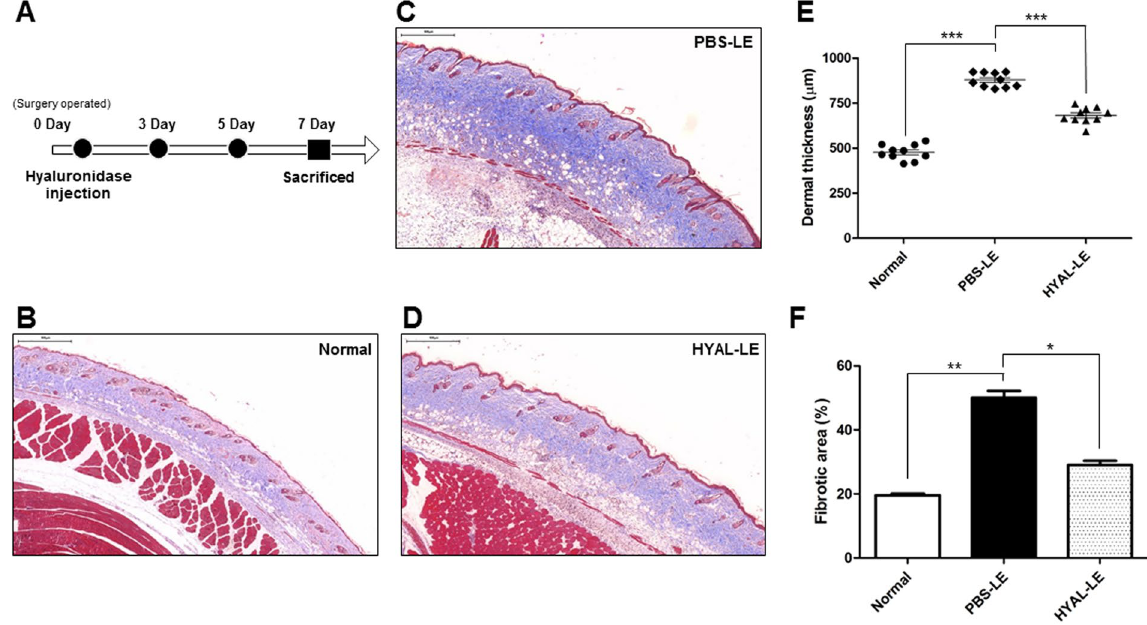
Figure 2. Subcutaneous injection of hyaluronidase alleviates lymphedema in a mouse model. At 7 days postsurgery, PBS-injected mice with lymphedema (PBS-LE) and hyaluronidase-injected mice with lymphedema (HYAL-LE) were sacrificed. Cross-sections of the legs with edema were then analyzed. ( A,B , C ) Representative Masson’s trichrome staining of fibrotic areas. Scale bar = 500 μ m. ( D,E ) Image J analysis of dermal thickness and fibrotic (blue) areas. Data are presented as means ± SEMs. * P < 0.05, ** P < 0.005, *** P < 0.001. ( F )